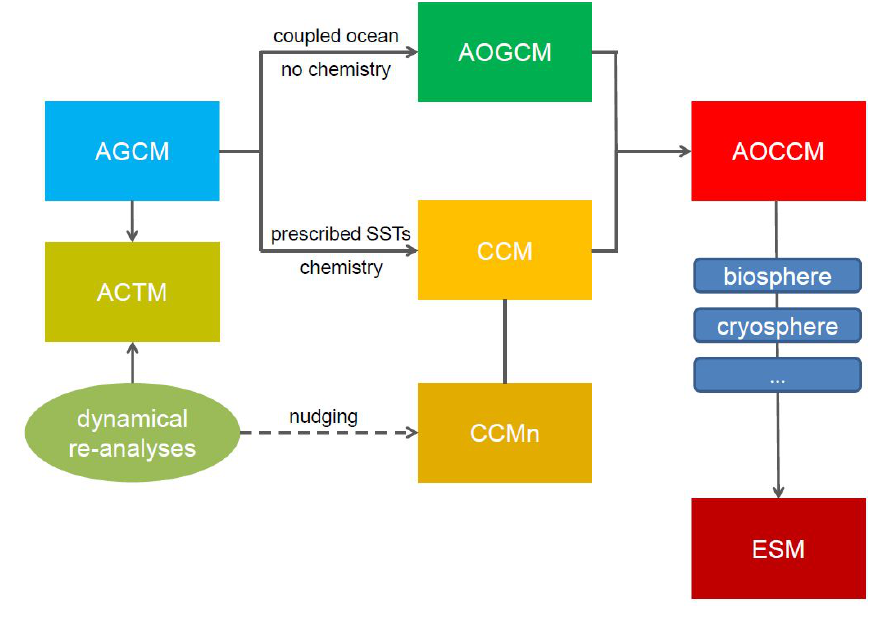
Figure 1. Schematic of global model systems to study climate change and climate-chemistry connections. AGCM: Atmospheric General Circulation Model; ACTM: Atmospheric Chemistry Transport Model; AOGCM: Atmosphere-Ocean General Circulation Model = global climate model; CCM: Chemistry-Climate Model; CCMn: “nudged” CCM; AOCCM: Atmosphere-Ocean Chemistry-Climate Model = global climate model with interactive chemistry; ESM: Earth-System Model. See text for detailed